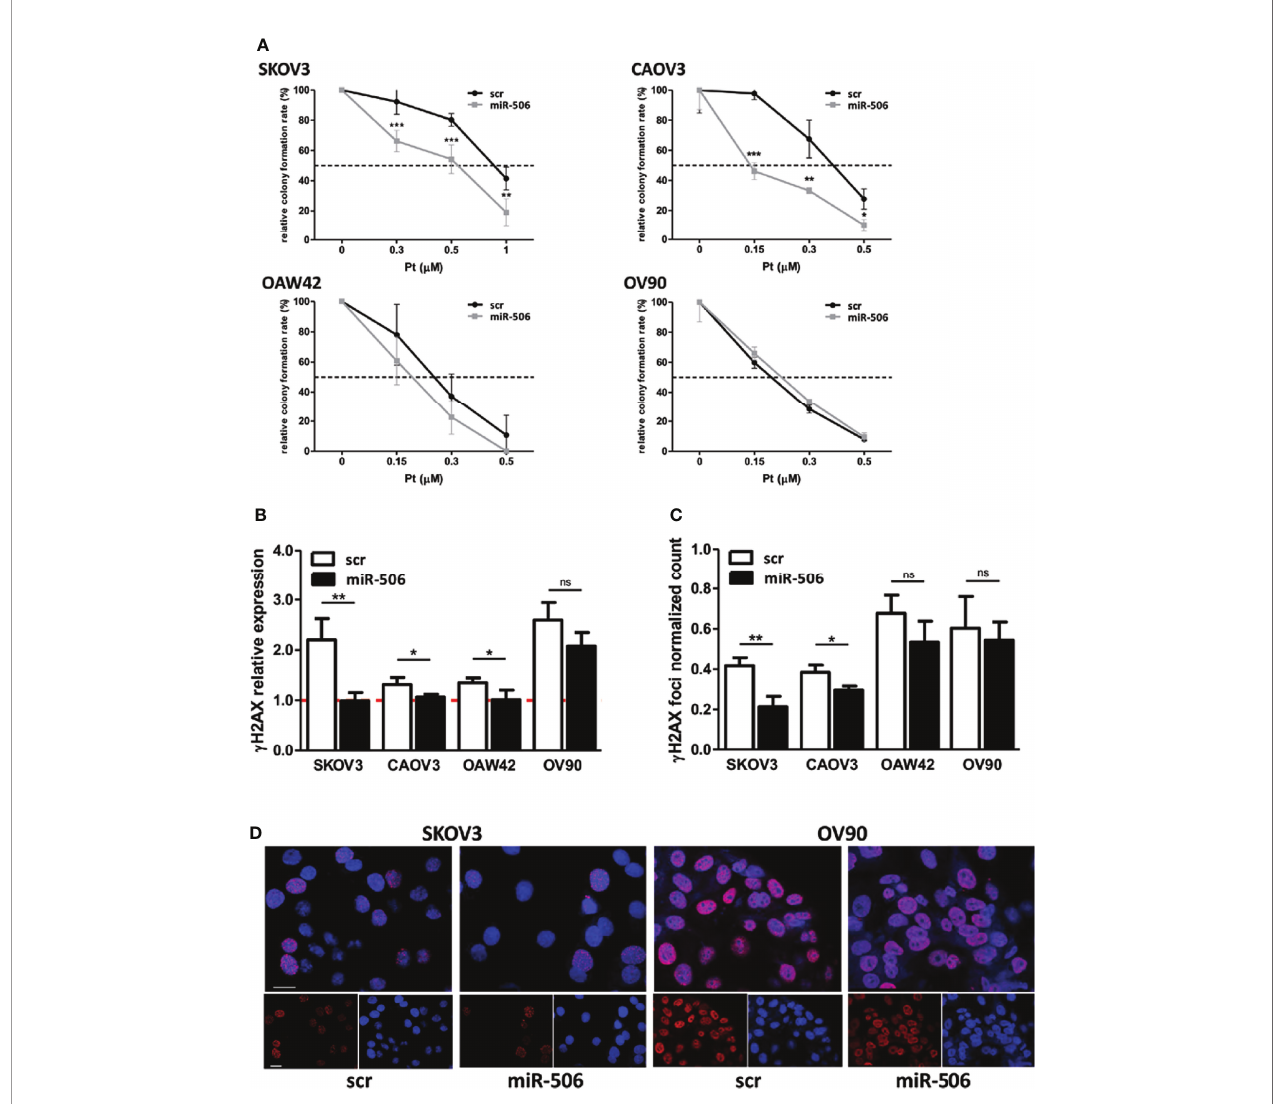
FIGURE 1 | Forced expression of miR-506-3p increased platinum sensitivity in EOC cell lines and impaired sensing of DNA damage. (A) Clonogenic assay on EOC cell lines transfected with scrambled (scr) control miR or miR-506-3p (miR-506) mimic and treated with platinum (Pt) at the indicated concentrations. Curves were generated from two to four independent experiments, each one performed in triplicates. Two way ANOVA and Bonferroni ’ s post test was used for statistical analysis (*p<0.05; **p<0.01; ***p<0.001). (B) Assessment of relative g H2AX expression in EOC cells transfected with miR-506-3p mimic (miR-506) or scrambled (scr) control miR and treated with 1 m M (CAOV3,OAW42, OV90) or 3 m M (SKOV3) Pt corresponding to the IC50 of each cell line as de fi ned by TiterGlo/SRB assay. For Western Blot analysis, lysates were collected at 24 hours after Pt-treatment; vinculin was used as loading control. Bars represent the ratio of g H2AX expression (normalized on vinculin) between Pt-treated and untreated cells (dashed red line represents g H2AX expression in untreated cells). Student ’ s t-test was used to compare miR-506 versus scr treated cells (* p<0.05; ** p<0.01; ns = not signi fi cant). Quanti fi cation (C) and representative images (D) of g H2AX foci in miR-506-3p/scr transfected OC cell lines. (C) Cells were treated as indicated in B and IF-stained with g H2AX and DAPI (nuclei). The percentage of g H2Ax foci/DAPI positive of treated vs untreated cells is reported. Student ’ s t-test was used to compare miR-506-3p versus scr treated cells (*p<0.05; **p<0.01; ns = not signi fi cant). (D) Representative confocal IF images of fi xed SKOV3 and OV90 cells treated as described in panel B and stained with anti- g H2AX (red); nuclei were stained with DAPI (blue). Bars, 25 m